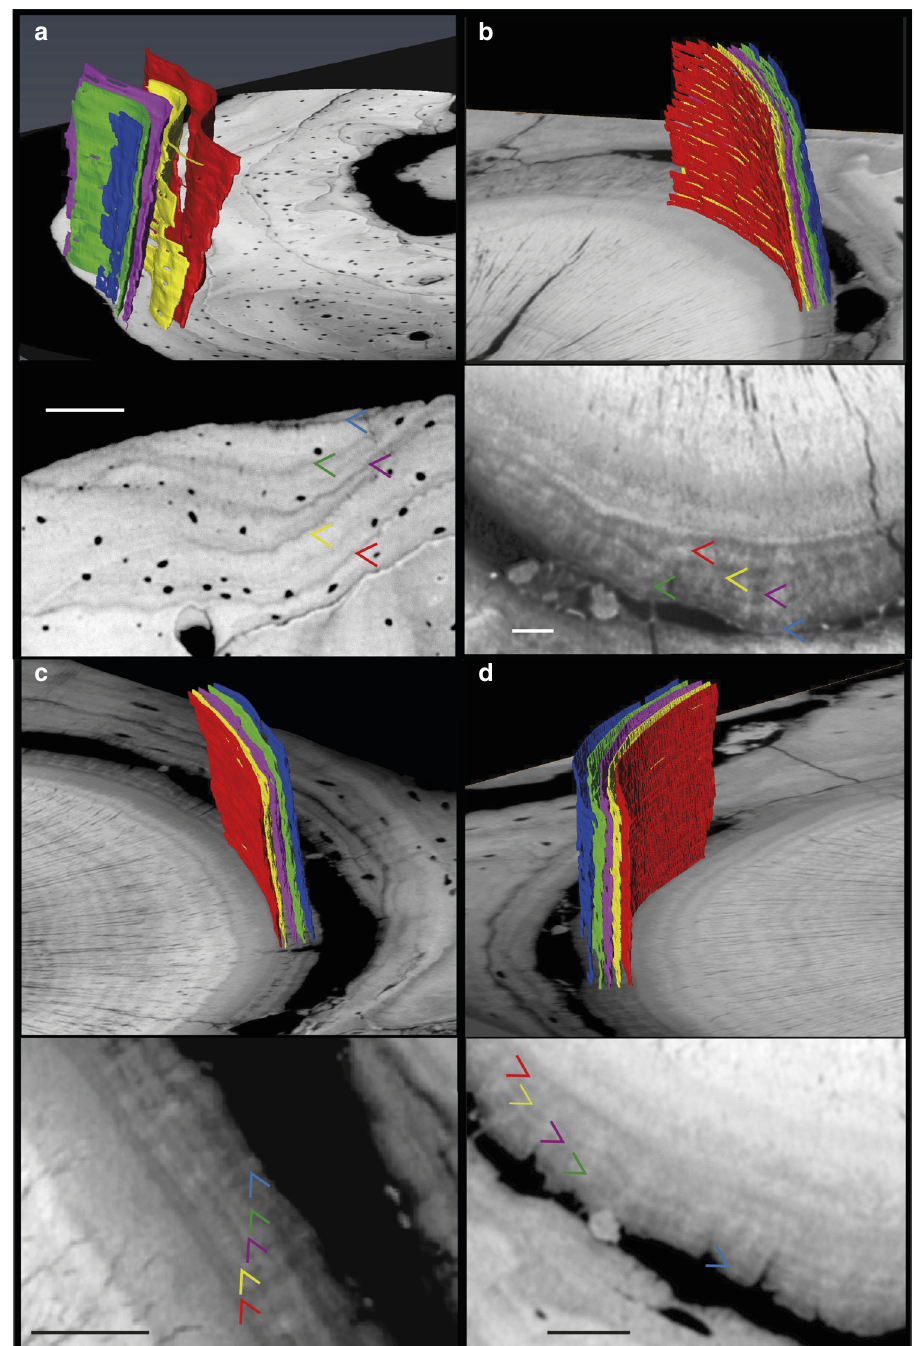
Fig. 4 Shared increment patterns between m1 and m2 tooth-root cementum and the dentary of Morganucodon specimen NHMUK PV M 96413. a Four lines of arrested growth and a fi fth incipient one are visible within the periosteal region of the dentary, each highlighted by three-dimensional segmented bands of differing colour corresponding to coloured arrows in the accompanying transverse PPC-SR µ CT slice. Only LAGs persisting through the volume are segmented and highlighted. This pattern is mirrored in b the anterior root of the m1 tooth, c the posterior root of the same m1 tooth and d the anterior root of the m2 tooth. Scale bars represent 30 µ